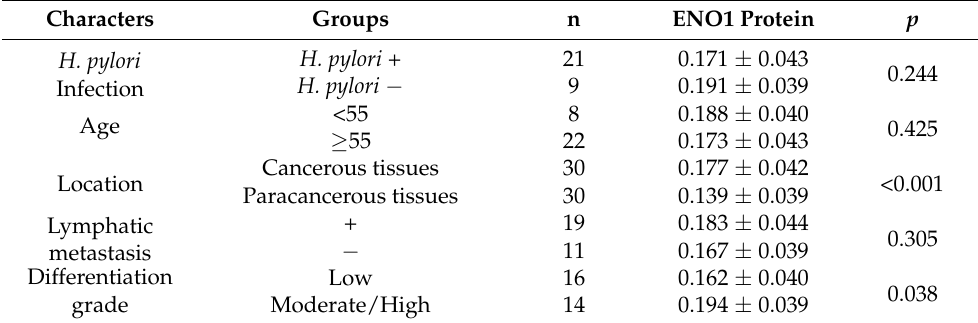
Table 3. Expression levels of ENO1 in the gastric cancerous tissues.